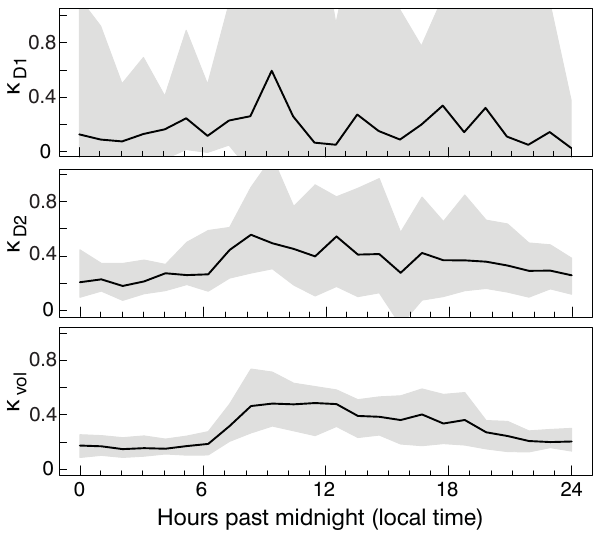
Figure 8. The top, middle, and bottom panels depict diurnal trends of smaller diameter mode, larger diameter mode, and volumetric κ , respectively. The trends are campaign-averaged and binned into hourly intervals. The central lines indicate the median values and the shaded area represents interquartile range.